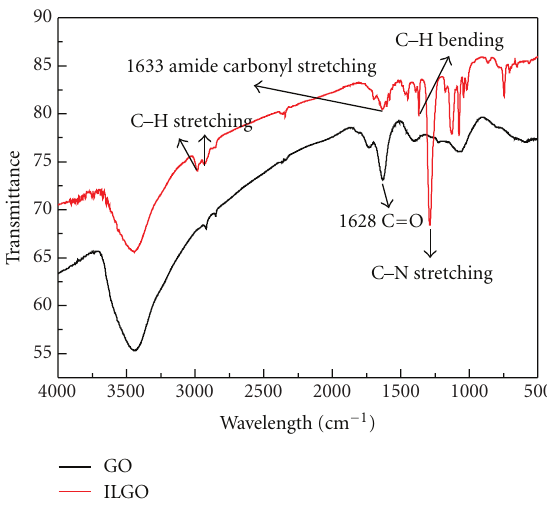
Figure 2: FTIR of GO (black) and ILGO